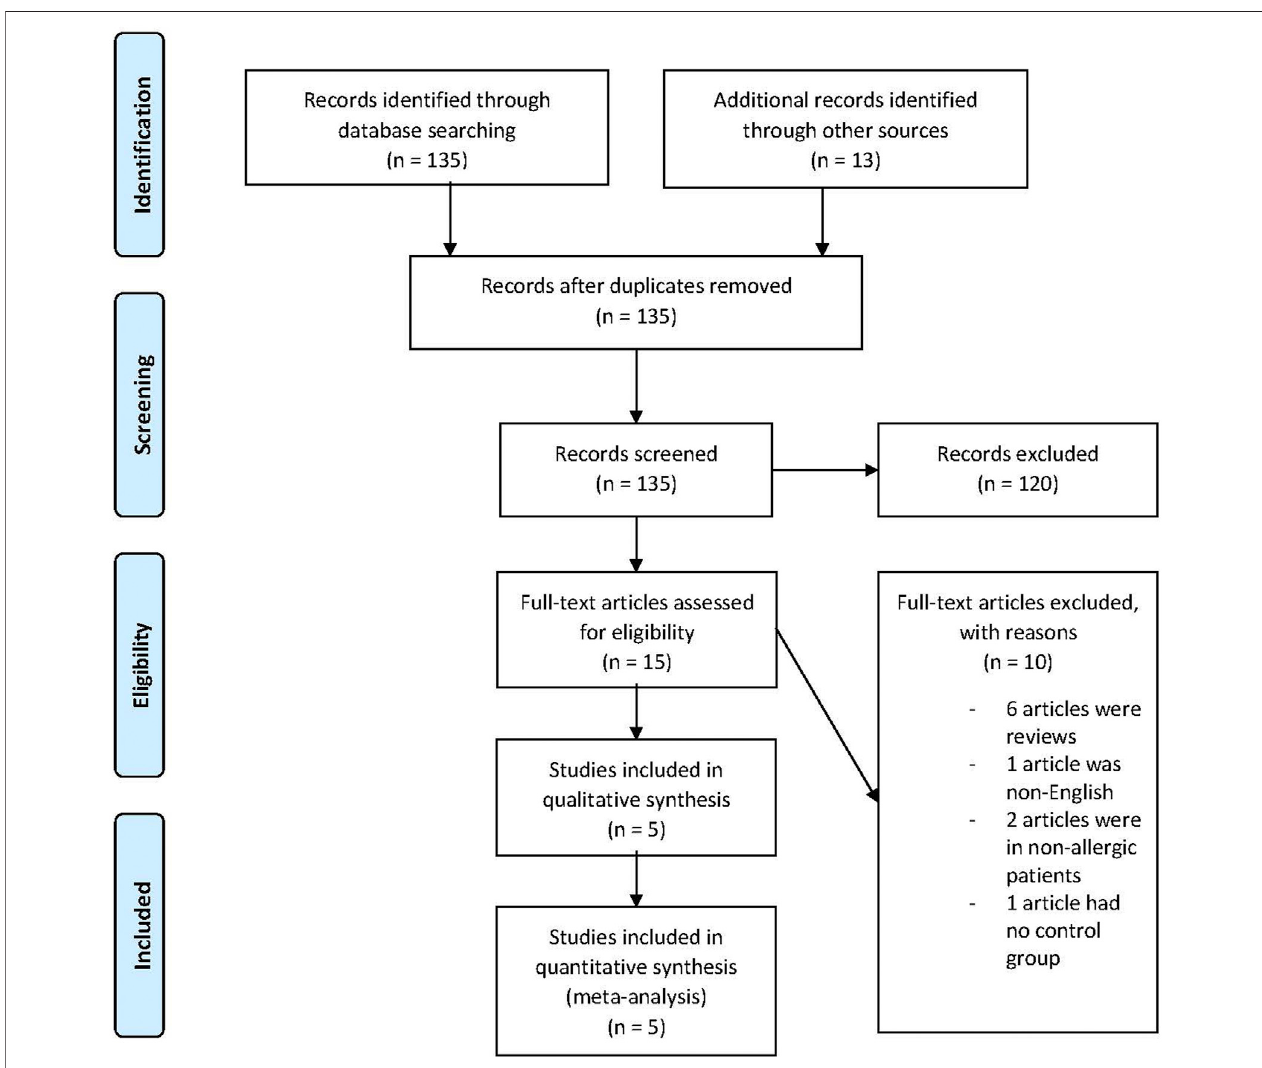
FIGURE 1 | Flow diagram of study